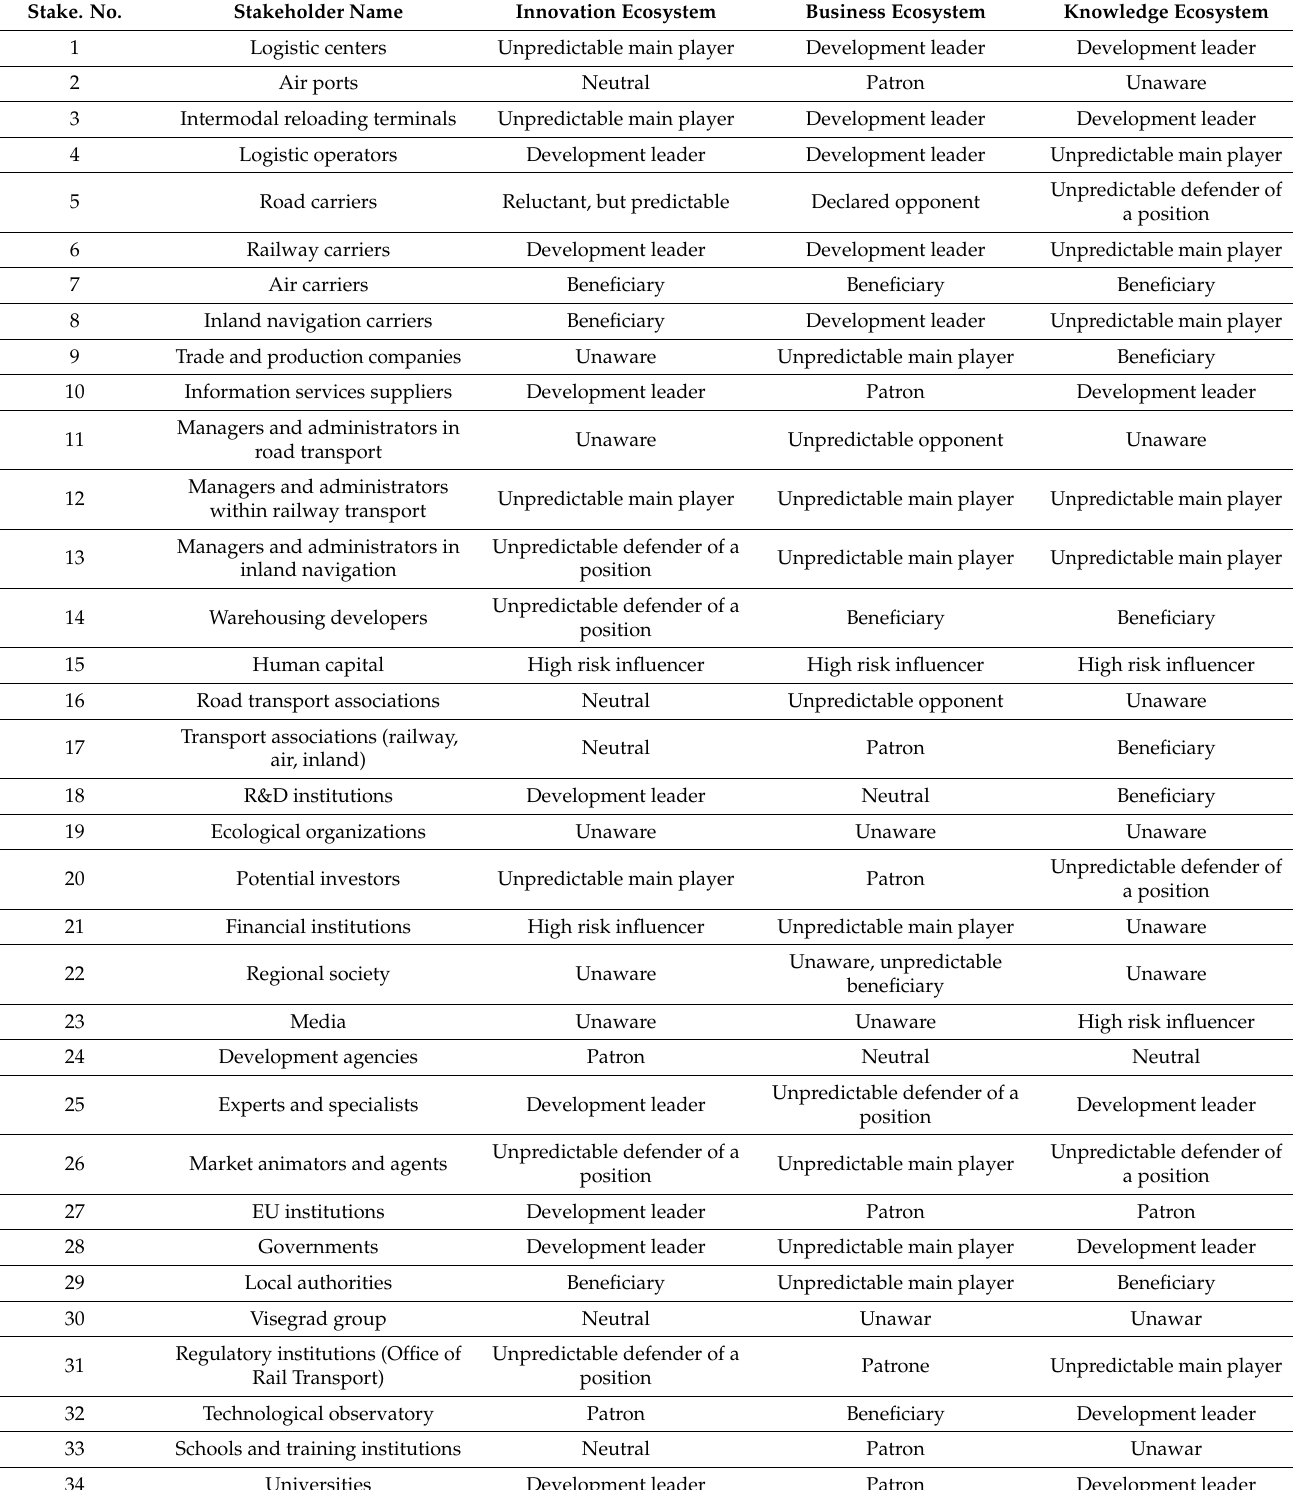
Table 6. Role of individual